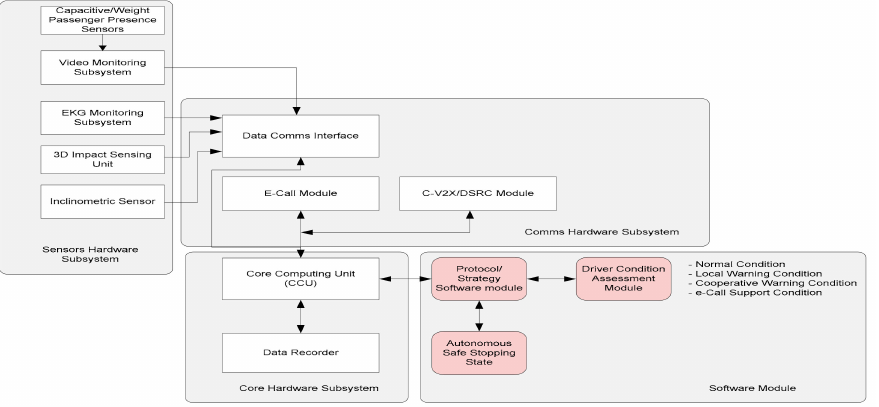
Figure 1. The onboard system